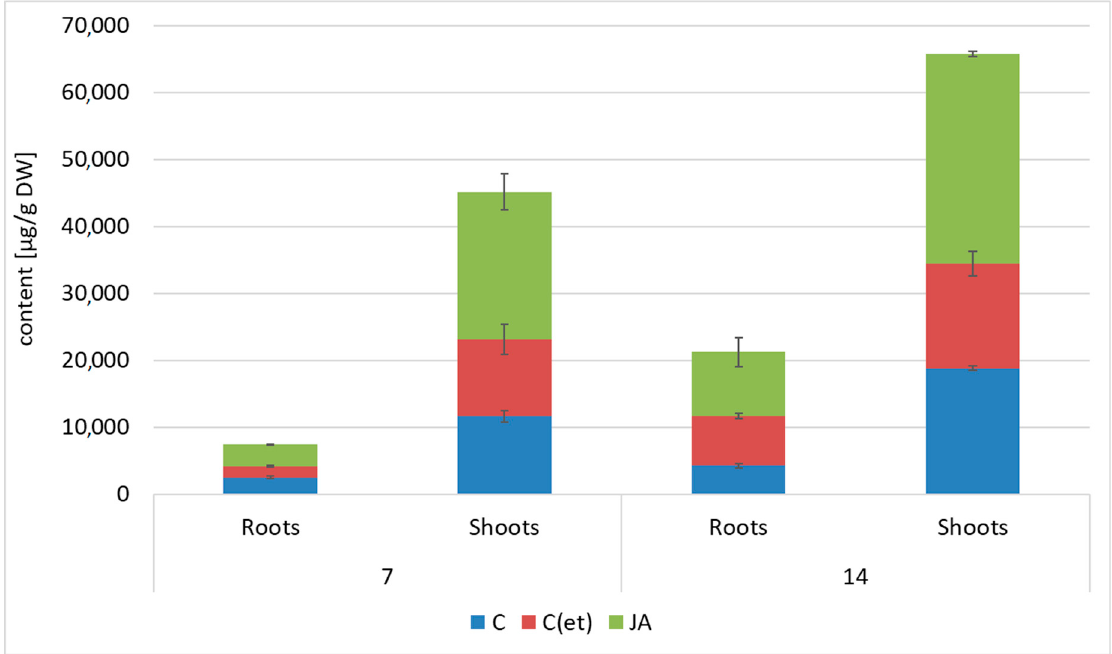
Figure 15. The content of saponins in roots and shoots of C. officinalis plants. C—control, C(et)—control samples treated with the adequate volume of 70% ethanol, JA—jasmonic acid-elicited samples. See detailed data and statistical significance in Table S27.